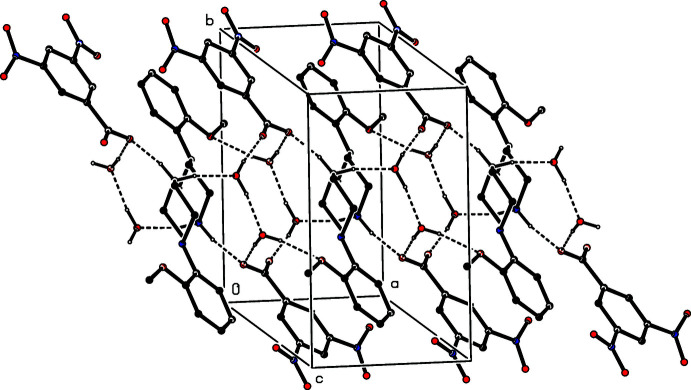
Part of the crystal structure of compound (XI) showing the formation of a hydrogen-bonded ribbon running parallel to [100]. Hydrogen bonds are drawn as dashed lines and, for the sake of clarity, the H atoms bonded to C atoms have been omitted.